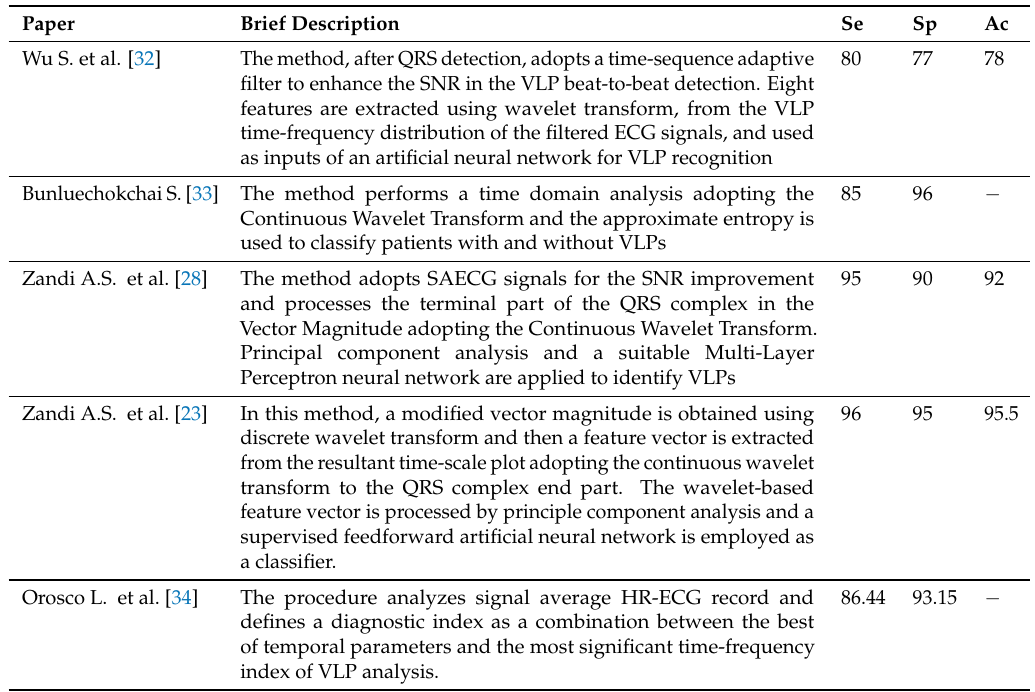
Table 2. Performance comparison of different CAD